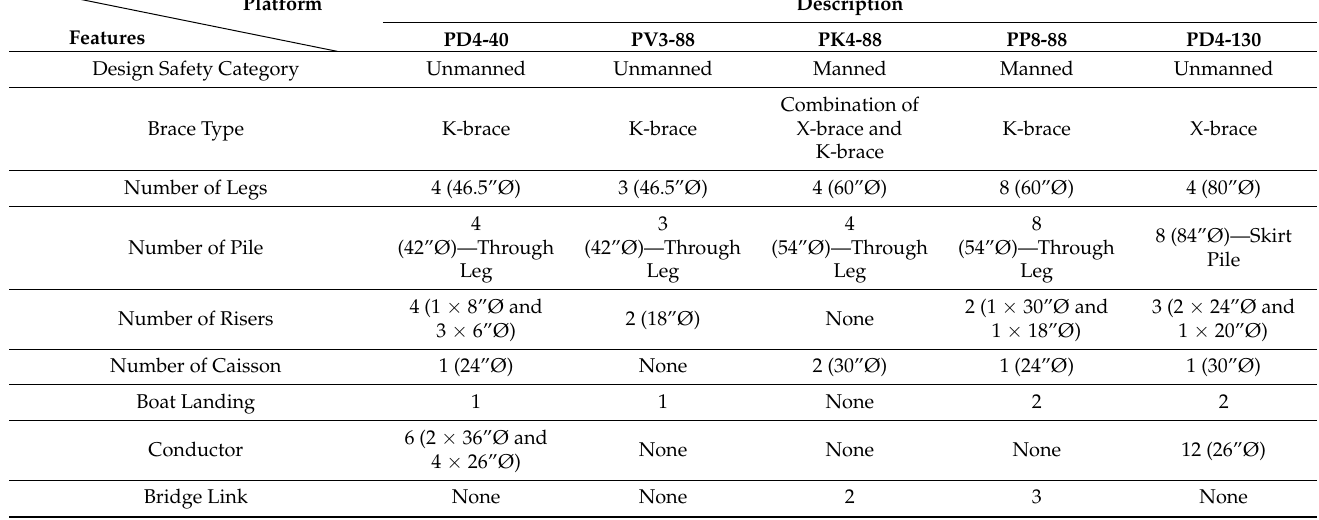
Table 2. Detailed specifications of the